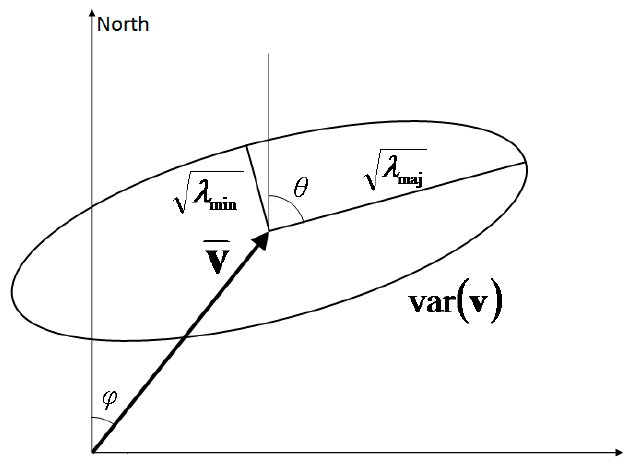
Figure 1. Schematic representation of the mean vector and variance tensor. The angles of φ and θ are also shown on the diagram.